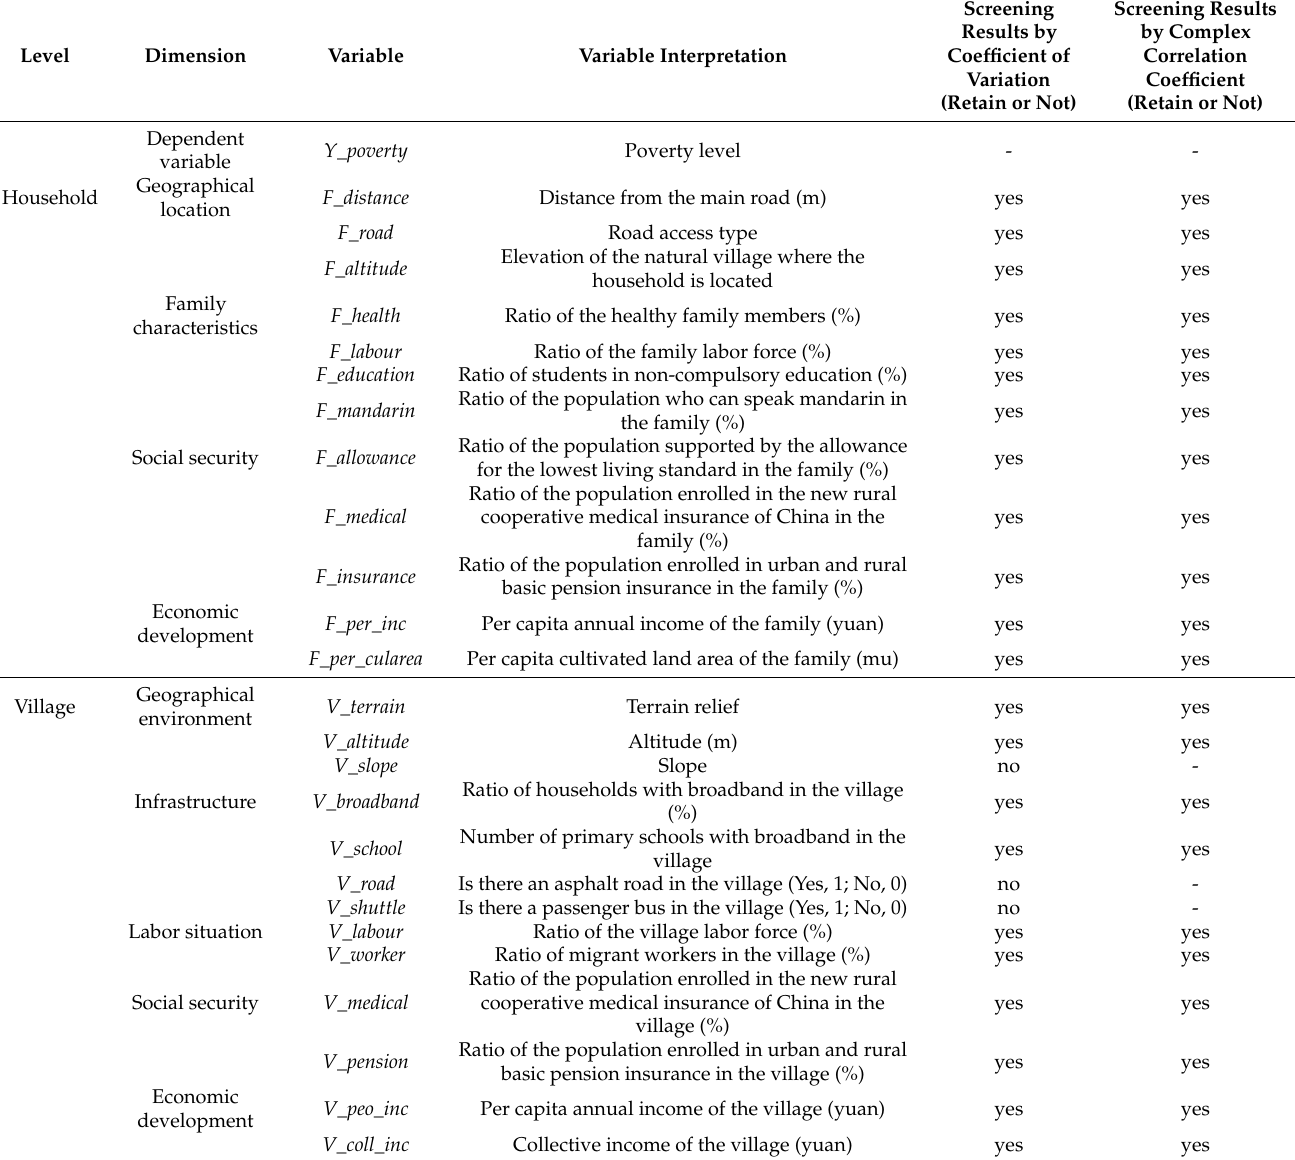
Table 1. Candidate indicators and screening at both household level and village